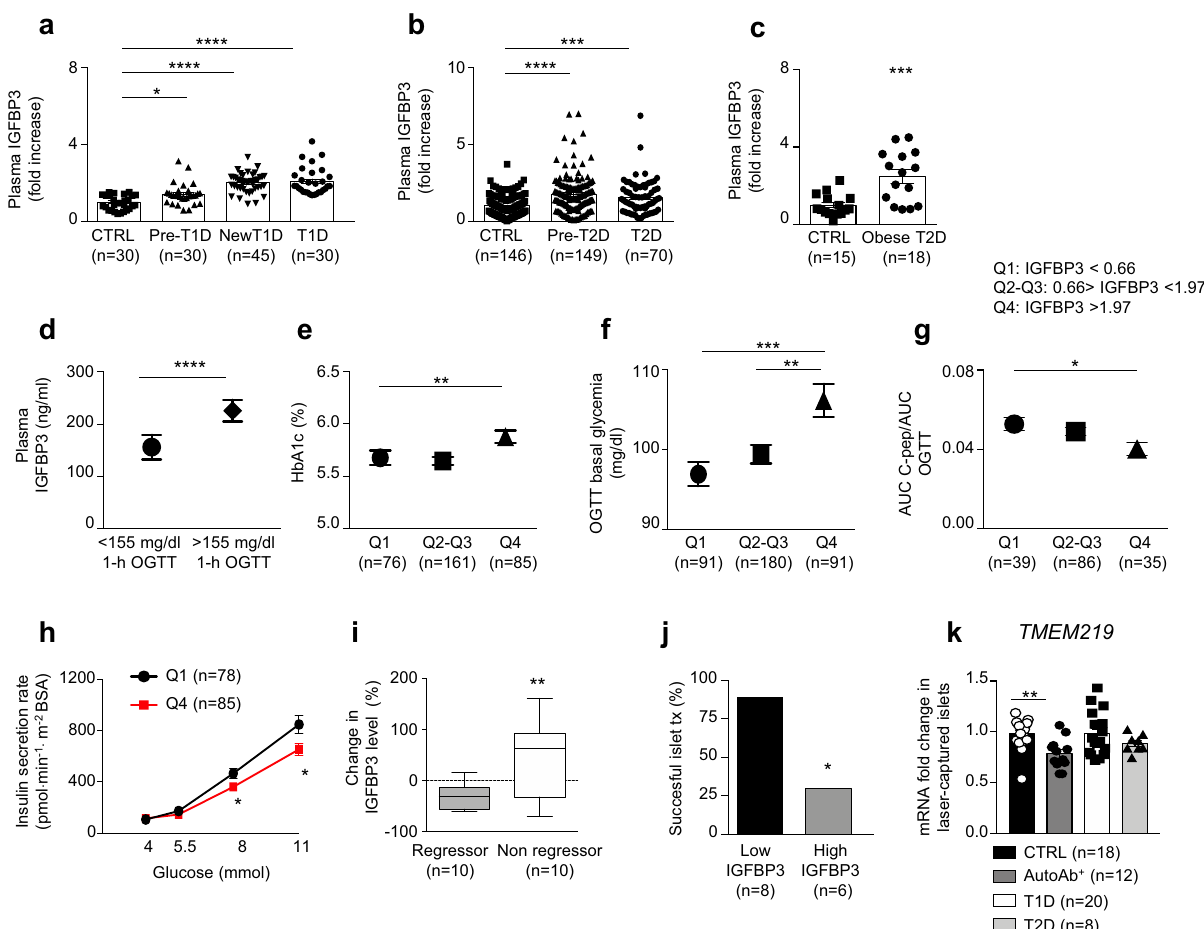
Fig. 2 Peripheral levels of TMEM219 ligand IGFBP3 are altered in diabetic patients. a Scatter plots representing fold increase in peripheral IGFBP3 in patients with established T1D ( n = 30), with new-onset T1D ( n = 45), at risk for developing T1D (with at least one detected autoantibody, pre-T1D, n = 30), as compared to non-diabetic healthy controls (CTRL, n = 30). Demographic characteristics are reported in Supplementary Table 1. b Scatter plots representing fold increase in peripheral IGFBP3 patients with newly diagnosed T2D ( n = 70), at risk for developing T2D (with altered glucose tolerance, pre-T2D, n = 149) as compared to non-diabetic healthy controls (with normal glucose tolerance, NGT, n = 146). Demographic characteristics are reported in Supplementary Table 2. c Box plot showing fold increase in peripheral IGFBP3 in obese T2D patients undergoing bariatric surgery ( n = 18, white) as compared to non-diabetic healthy controls ( n = 15, black). d Bar graph representing mean ± SEM peripheral IGFBP3 in patients with 1- h blood glucose level >155 mg/dl ( n = 256) at the oral glucose tolerance test (OGTT) as compared to those with a 1-h blood glucose level <155 mg/dl ( n = 105), within the cohort shown in panel b (NGT, pre-T2D and T2D groups). e , f , g Single scatter plot representing mean ± SEM percentage of HbA1c ( e ), OGTT basal glycemia ( f ) and C-peptide AUC/OGTT AUC ratio ( g ) measured in quartiles subgroups of IGFBP3 showed in panel b (NGT, pre-T2D, and T2D groups) and established as following: <0.66 (Q1), ranging between 0.66 – 1.97 (Q2-Q3) and >1.97 (Q4). ( h ). Line graph comparing insulin-secretion rate measured at different glucose concentrations (4, 5.5, 8, and 11 mM) in Q1 and Q4 IGFBP3 quartiles subgroups shown in panel b (NGT, pre-T2D and T2D groups). i Box plot depicting percent change in peripheral IGFBP3 levels measured in diabetic patients who underwent liver transplantation and who near-normalized (gray) glycometabolic control after transplantation (regressor) or remained diabetic (white, non-regressor). All box plots include the median line, the whiskers indicate the minimum and maximum value and the box of the box plot illustrates the upper and lower quartile (two-sided t test). Demographic characteristics are reported in Supplementary Table 3. j Bar graph representing the percentage of patients with successful islet transplantation (C-peptide >0.4 ng/ml) who displayed low (<1.92, Q1 – Q2) vs. high (>1.92, Q3 – Q4) peripheral IGFBP3 fold changes. k Bar graph representing TMEM219 mRNA expression by RNAseq in laser-captured islets obtained from human non-diabetic subjects (CTRL, n = 18), individuals with T1D ( n = 20), individuals at risk for T1D (AutoAb + , n = 12) and individuals with T2D ( n = 8). mRNA expression was expressed as fold change as compared to CTRL. Fold change was computed as the ratio of the changes between T1D, AutoAb + and T2D values and the CTRL value over the mean CTRL value. Data are expressed as mean ± standard error of the mean (SEM) unless otherwise reported. * P < 0.05; ** P < 0.01; *** P < 0.001, **** P < 0.0001 by Kruskal – Wallis adjusted for multiple comparison, Mann – Whitney U test, one-way ANOVA followed by Bonferroni post hoc test, two-way ANOVA, two-sided t test and Chi-square test. Source data are provided as a Source Data fi le. CTRL healthy volunteers, T1D type 1 diabetes, pre-T1D patients showing positive results for at least one autoantibody, AutoAb autoantibodies, T2D type 2 diabetes, NGT normal glucose tolerance, IGT impaired glucose tolerance, New T1D new-onset T1D, Q quartile, vs versus, qRT-PCR quantitative real-time polymerase chain